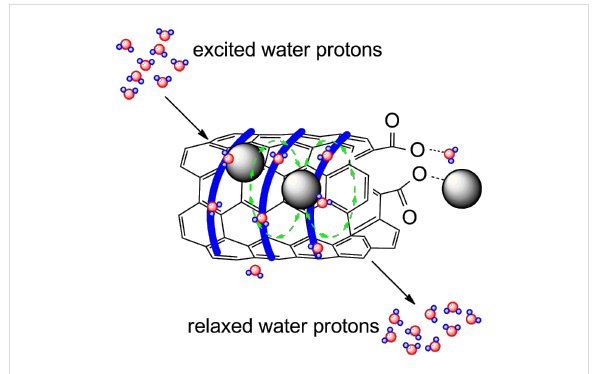
Figure 4: Relaxation enhancement of water protons by the MWCNT